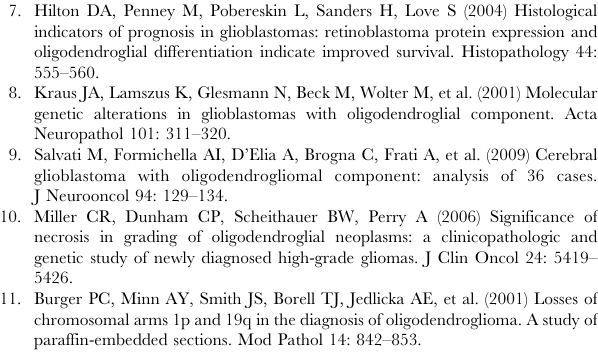
Figure S2 Survival analysis based on 1p loss status or histological subclassification. The graph shows comparison of progression-free survival (PFS) or overall survival (OS) according to 1p loss status (a, b) and histological subclassification (c, d). Although any of them shows no statistical siginificance between them, oligodendroglial tumor is associated with longer survival. Figure S3 The overlayed survival curves. The survival curves of the Grade III and oligodendroglial tumor (AO, AOA, GBMO; oligo), and Grade IV and pure astrocytic tumor (AA, GBM; pure astro) were almost identical, respectively. (TIF) Table S1 The result of FISH analysis for 1p36 loss.